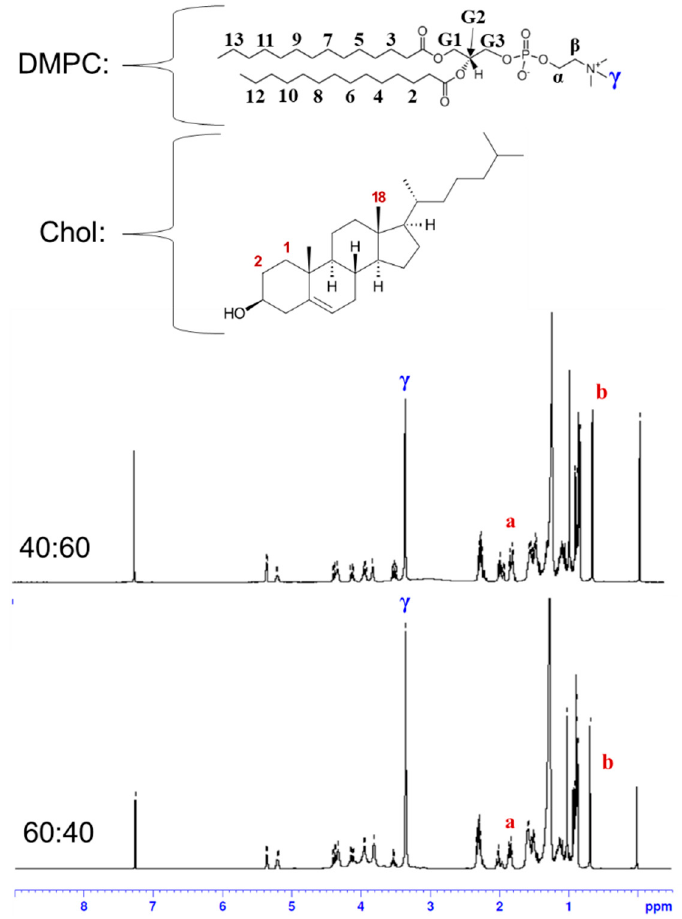
Figure 2. 1 H NMR spectra of liposomes formulated from the lipid films with DMPC:Chol molar ratios of 40:60 and 60:40. The a indicates the peak at 1.83 ppm from two protons on carbon 1 and one proton on carbon 2, and the b indicates the peak at 0.68 ppm from three protons on carbon 18 in cholesterol.